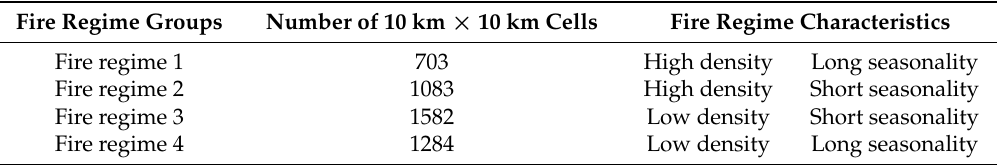
Table 1. Fire regime groups and fire regime characteristics data [32] used in this